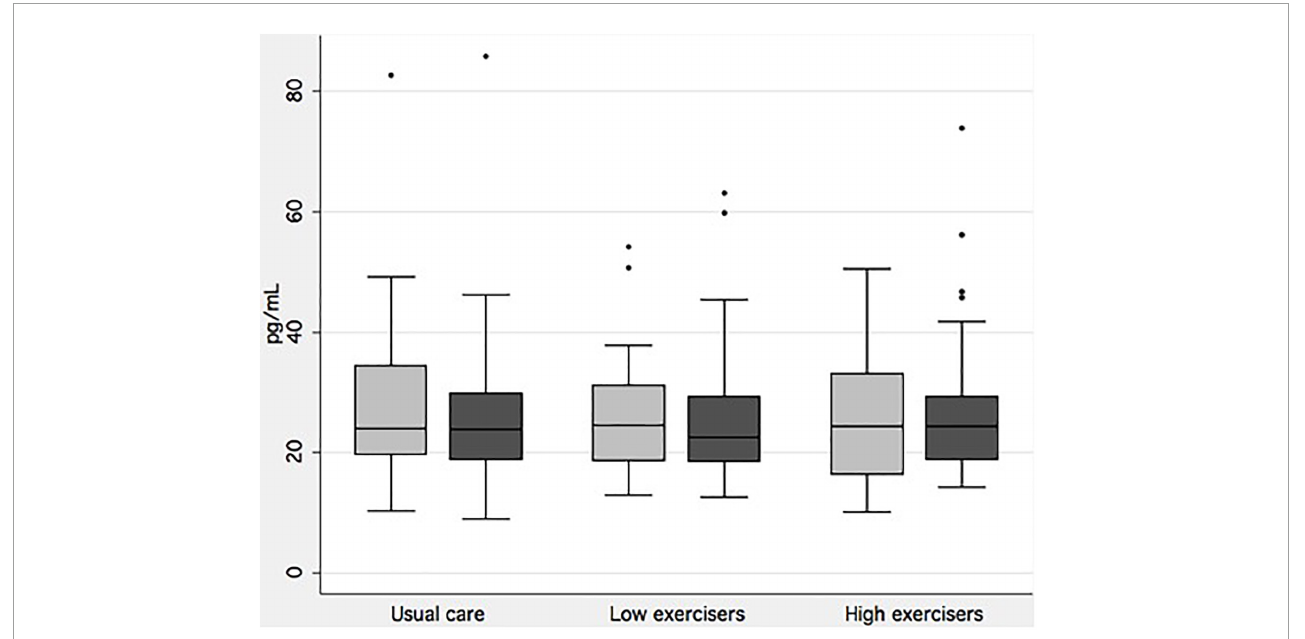
FIGURE2 Serum neurofilament light by exercise intensity. Boxplot of baseline (light gray) and follow-up measurements of neurofilament light chain for each group of exercise intensity achieved in the intervention group, and for the usual care group. There were no significant differences in changes from baseline to follow-up between